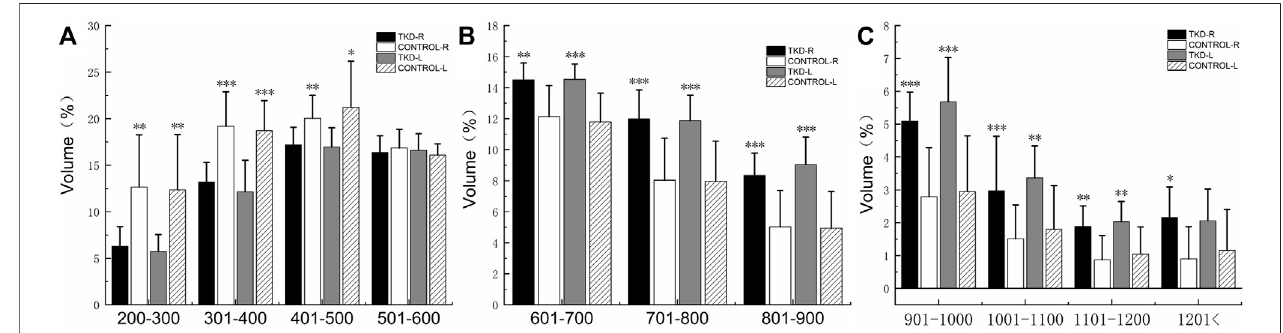
FIGURE7 | Comparison ofthe bone volume of each bone density zone in thetalus subchondralbone between the groups (%). (A) isthe bone volume oflowbone density; (B) is the bone volume of medium bone density; (C) is the bone volume of high bone density (***, **, and * indicate statistically signi fi cant p values of < 0.001, < 0.01, and < 0.05 in the control